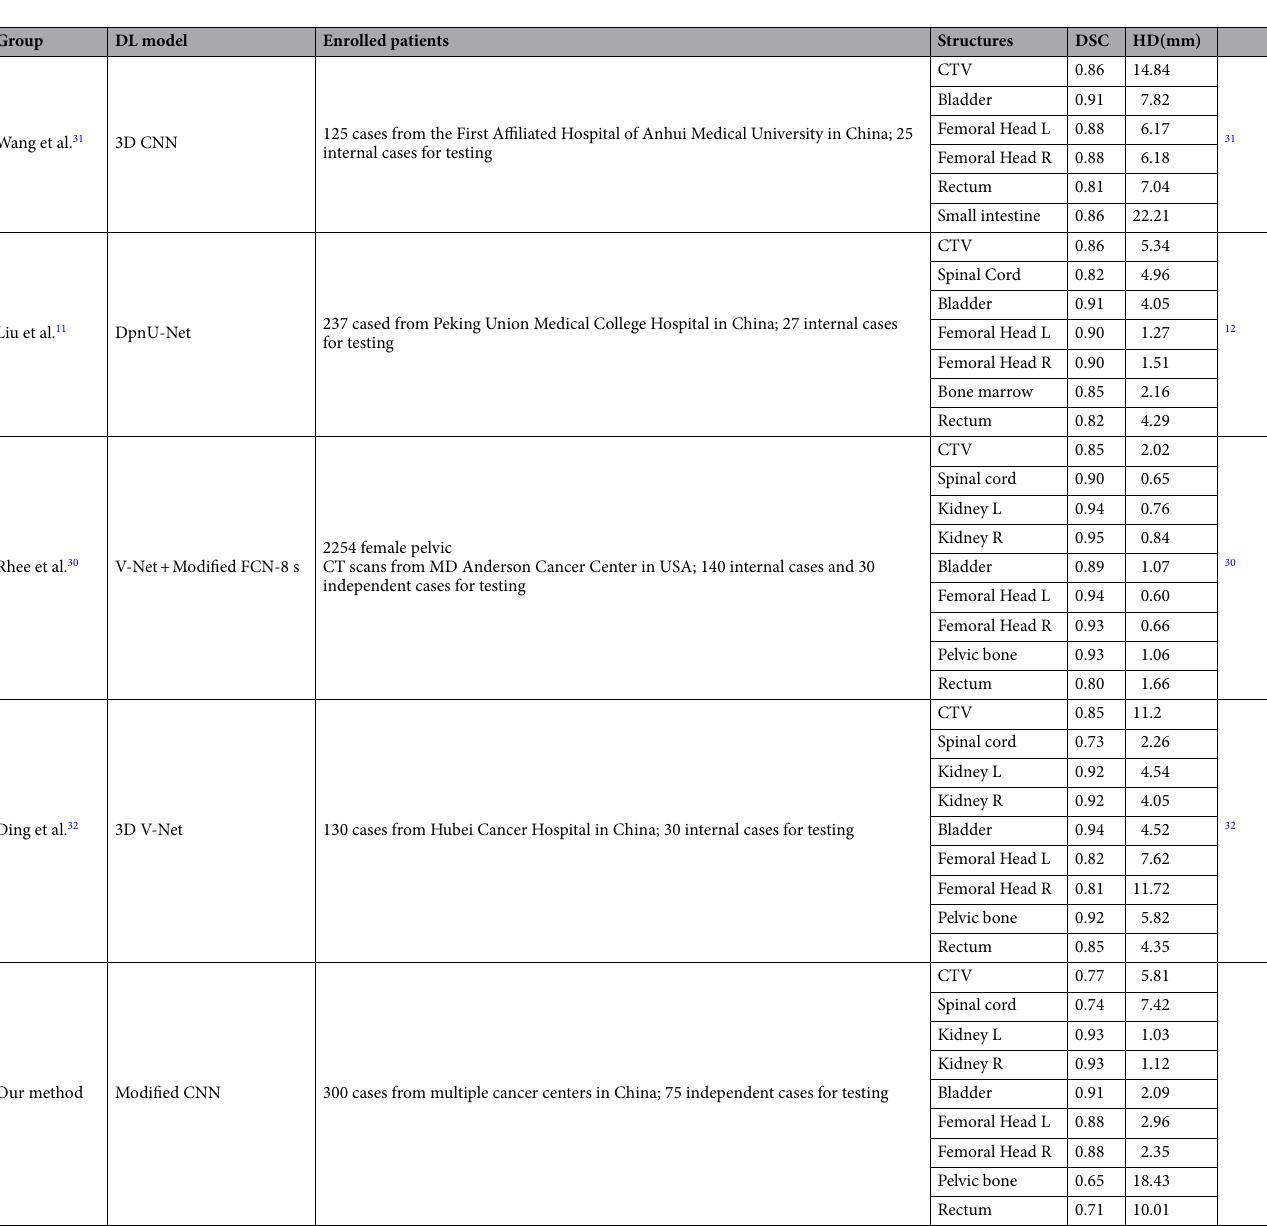
Table 4. Summary of DL based auto-segmentation results for CTV and OARs in cervical cancer from other published literature. CNN: convolutional neural network; DL model: deep learning